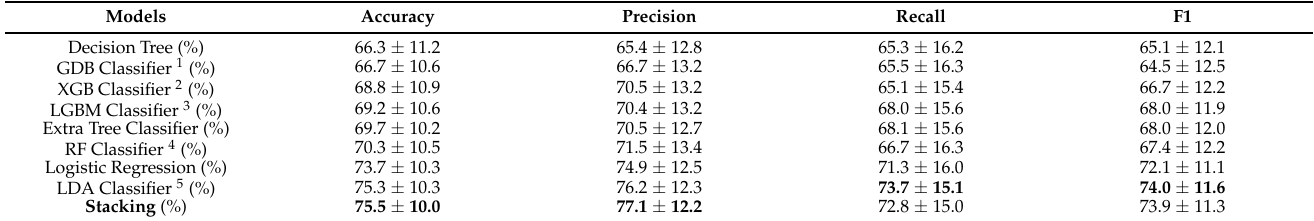
Table 3. However, Linear Discriminant Analysis had the best F1-score (71.3 ± 10.8%) and best recall (73.7 ± 15.1%). Table 3. Model performance evaluation results.